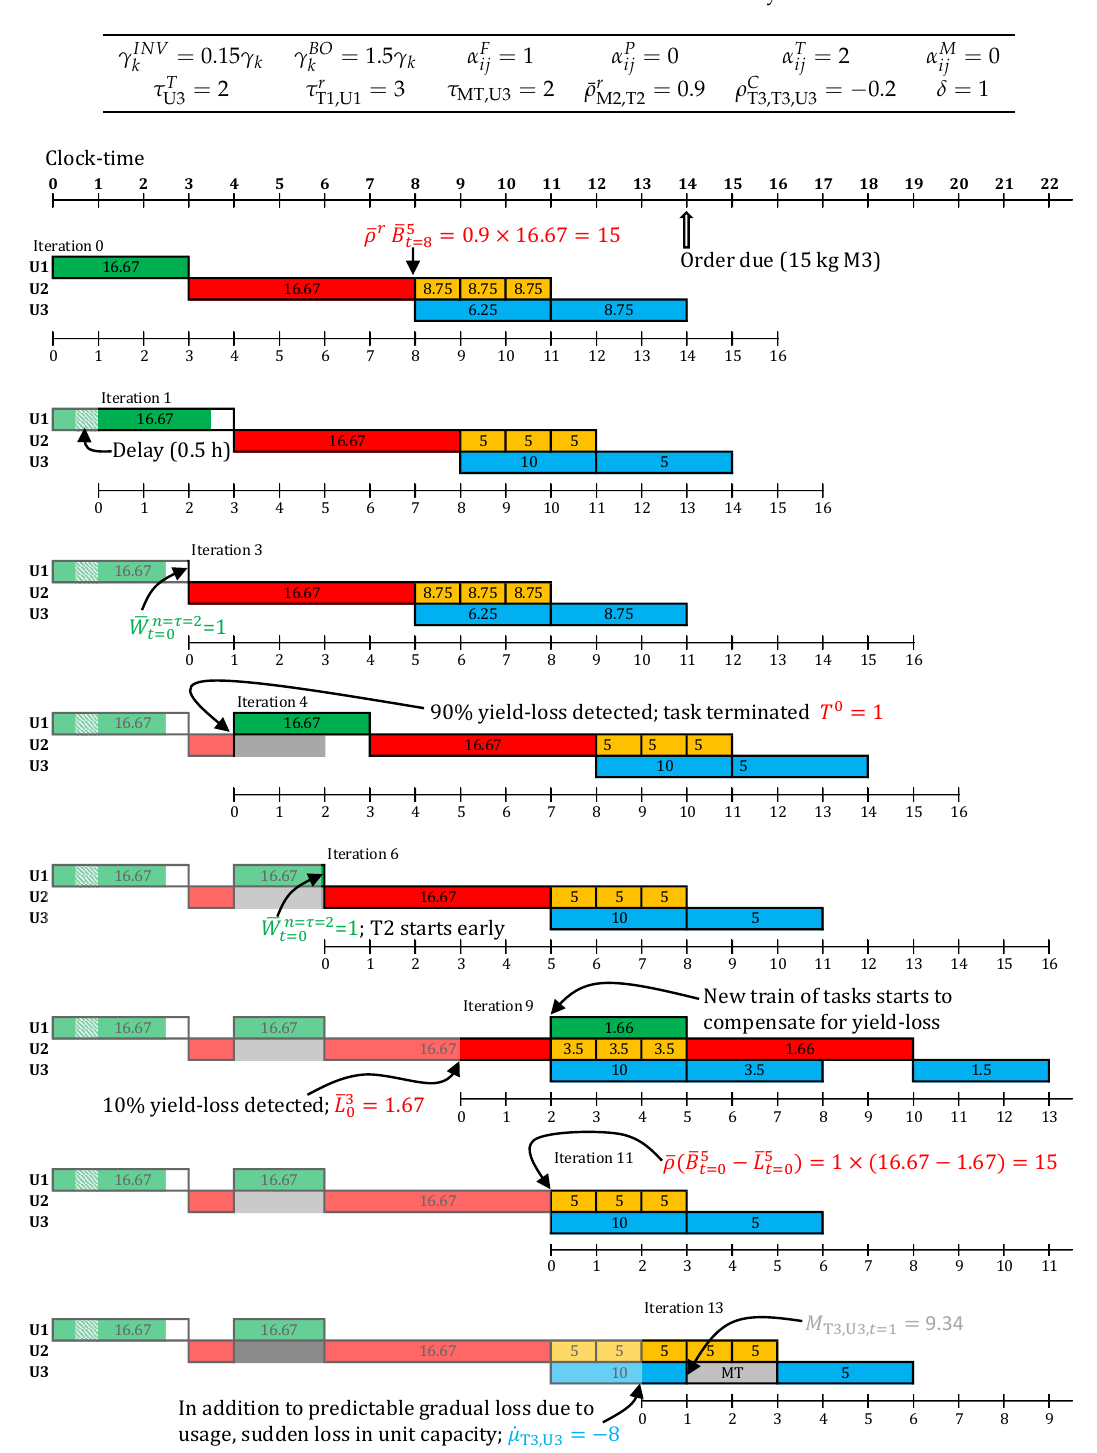
Figure 10. Selected online scheduling iterations for the case study. The color of the tasks corresponds to their color in Figure 1. Executed schedule, with respect to each iteration, is shown in lighter (fainted) colors. The clock-time is the global time. Each iteration has its own local discrete time-grid. An order for 15 kg of M3 is due at the 14th hour of the day. To meet this order, online scheduling is carried out, with a horizon of 16 h, and re-optimization every 1 h, starting at the 0th hour. All